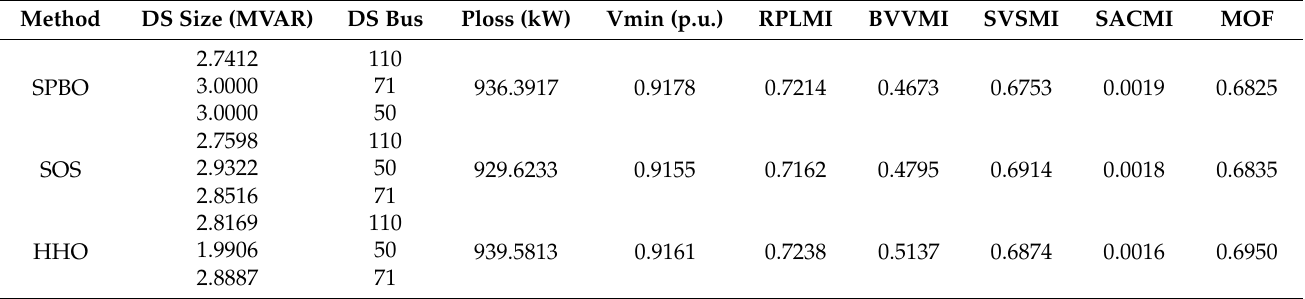
Table 4. Comparison of results for exclusive D-STATCOM allocation (case-2) for 118-bus test